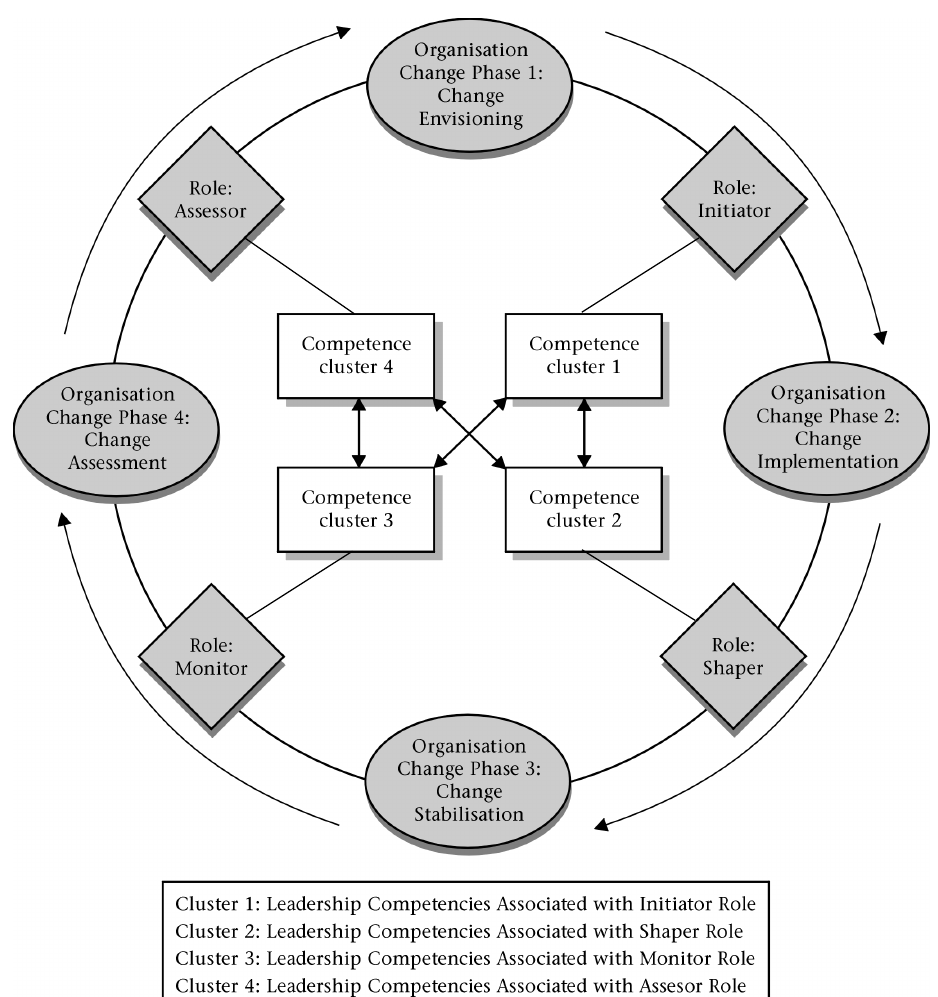
Figure 1: Integrated role competence cluster